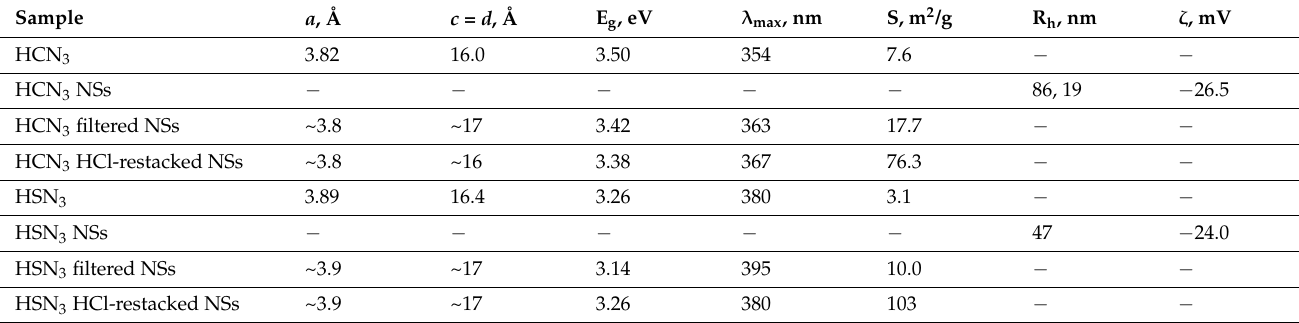
Table 1. Lattice parameters in the tetragonal system, interlayer distances, light absorption edges, specific surface areas of the protonated niobates and their reassembled nanosheets as well as hydro- dynamic radii and ζ -potentials of the pristine nanosheets in suspensions before